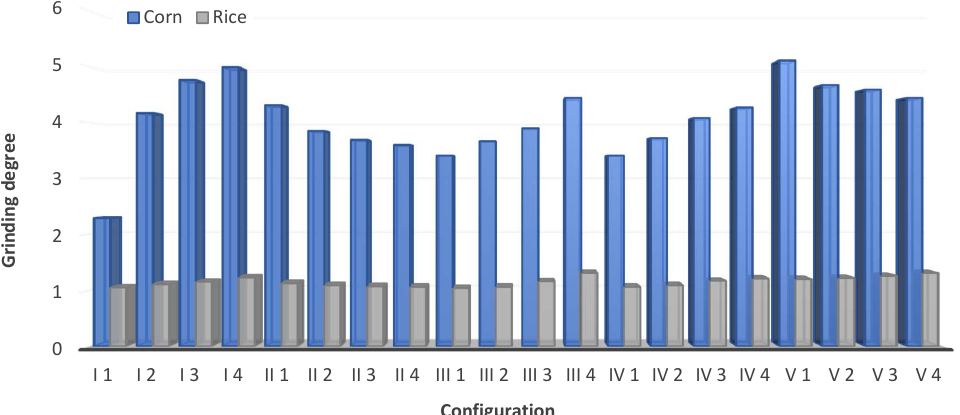
Figure 9. Test results of an 80% fragmentation degree for rice and corn grinding.